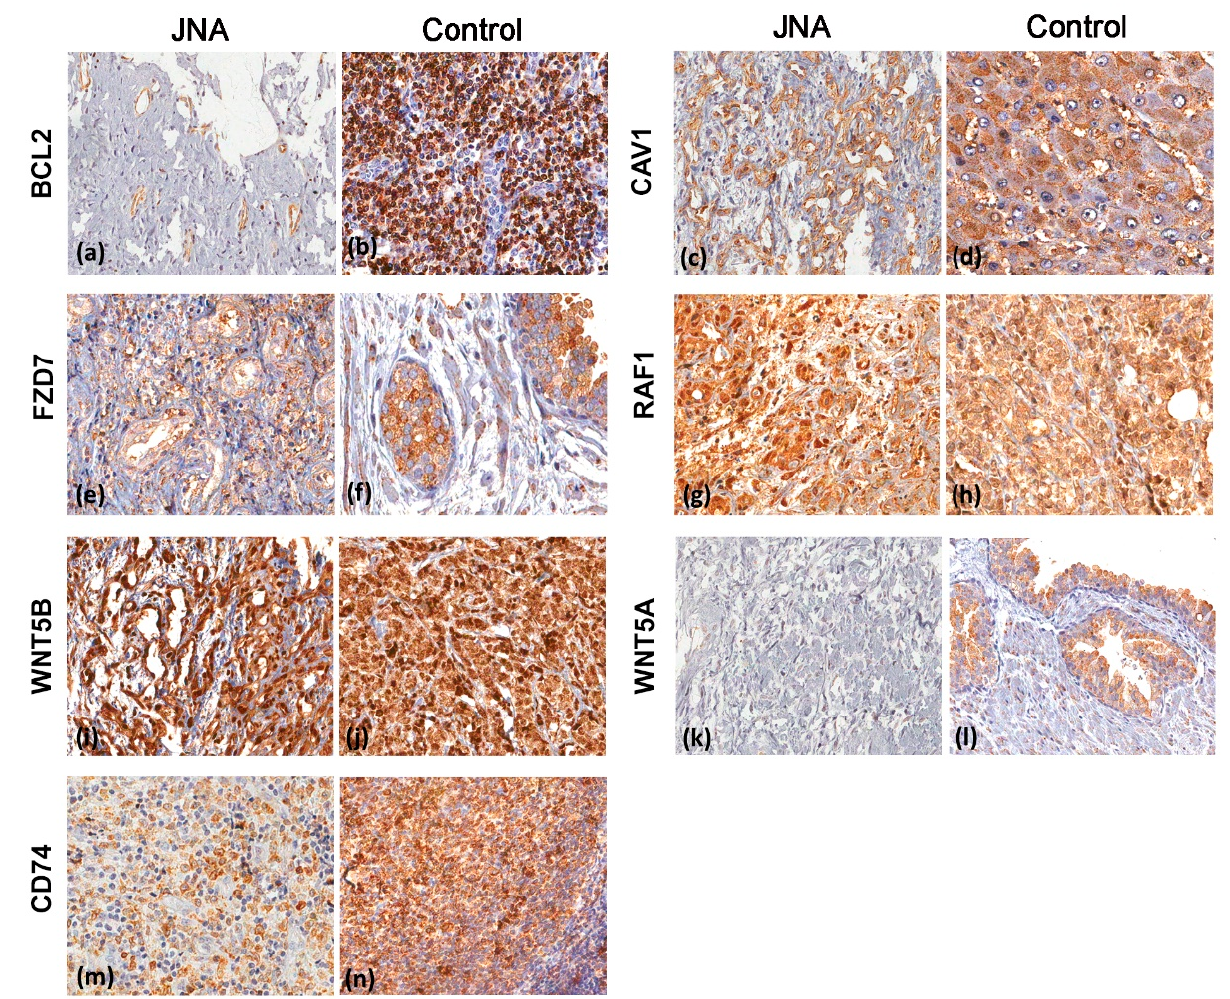
Figure 3. Immunohistochemical analysis of different markers in 40 juvenile nasopharyngeal angiofibroma (JNA) and control samples: ( a ) moderate cytoplasmic BCL2 immunoexpression in the vascular structures of a JNA sample; ( b ) strong cytoplasmic BCL2 expression in a positive control (lymphoid tissue); ( c ) strong diffuse cytoplasmic and membranous CAV1 in neoplastic cells and absent expression in stromal cells; ( d ) strong cytoplasmic CAV1 expression in an adenoid sample; ( e ) moderate FZD7 expression in vascular structures and stromal cells of a JNA sample; ( f ) a normal nasopharyngeal sample (control) positive for FZD7; ( g ) strong cytoplasmic RAF1 expression in neoplastic, inflammatory, and stromal cells in JNA sample; ( h ) strong RAF1 expression in a positive control sample; ( i ) strong cytoplasmic WNT5B expression in vascular structures and inflammatory and stromal cells of a JNA sample; ( j ) strong WNT5B expression in the positive control; ( k ) negative WNT5A expression in neoplastic and stromal cells in a JNA sample; ( l ) WNT5A in a positive control